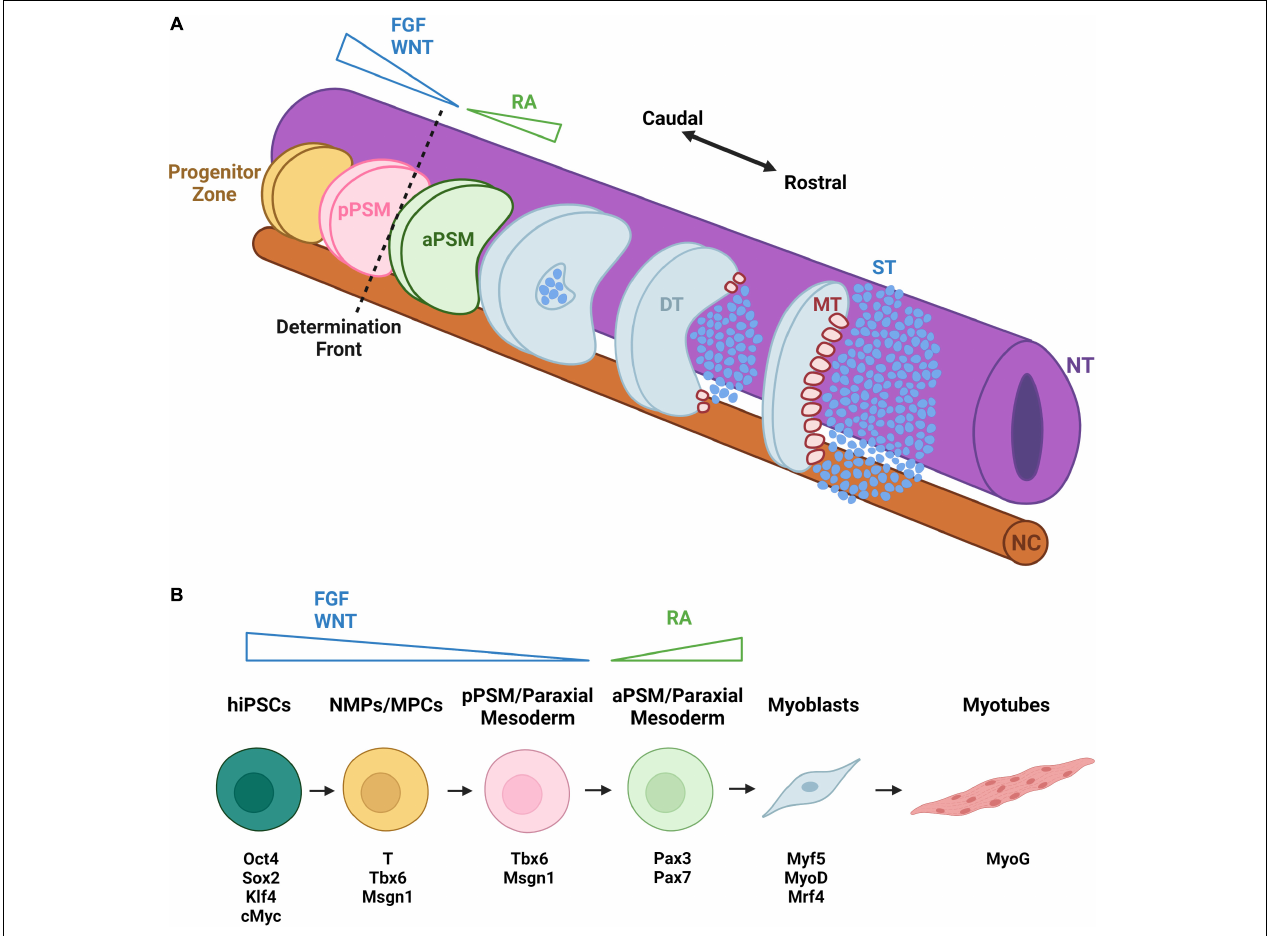
FIGURE 2 | Early development and hiPSC-based differentiation of skeletal muscle. (A) Caudal-rostral development of SkM occurs bilaterally along the neural tube (NT) and notochord (NC). From the progenitor zone, cells migrate to the posterior presomitic mesoderm (pPSM) with a decreasing gradient of FGF and WNT signals. They then cross the determination front to enter the anterior presomitic mesoderm (aPSM). With increasing retinoic acid (RA) gradient, somite formation begins. As cells continue to travel rostrally, the dermomyotome (DT), sclerotome (ST), and myotome (MT) form, initiating primary myogenesis. (B) hiPSC differentiation to skeletal muscle begins with WNT and FGF activation, inducing a shift into neuromesodermal progenitors (NMPs) and then muscle progenitor cells (MPCs) expressing the transcription factors T, Tbx6, and Msgn1. Subsequent loss of T expression leads to formation of paraxial mesoderm cells resembling skeletal muscle progenitors of pPSM. Through RA activation, these muscle progenitors begin to express the muscle stem cell markers Pax3 and Pax7 and eventually differentiate into myoblasts expressing early myogenic markers Myf5, MyoD, and Mrf4. The myoblasts can fuse into myotubes that express the late muscle differentiation marker MyoG. Distinct colors are used to denote approximate correspondence between stages of hiPSC differentiation in panel (B) and embryonic development in panel (A)